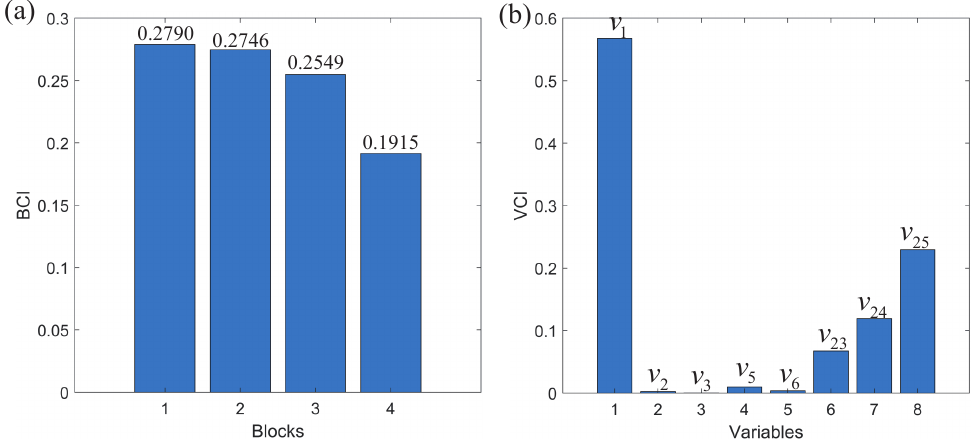
Figure 10. The anomaly isolation results in TE process with IDV (6). ( a ) BCI; ( b ) VCI-Block